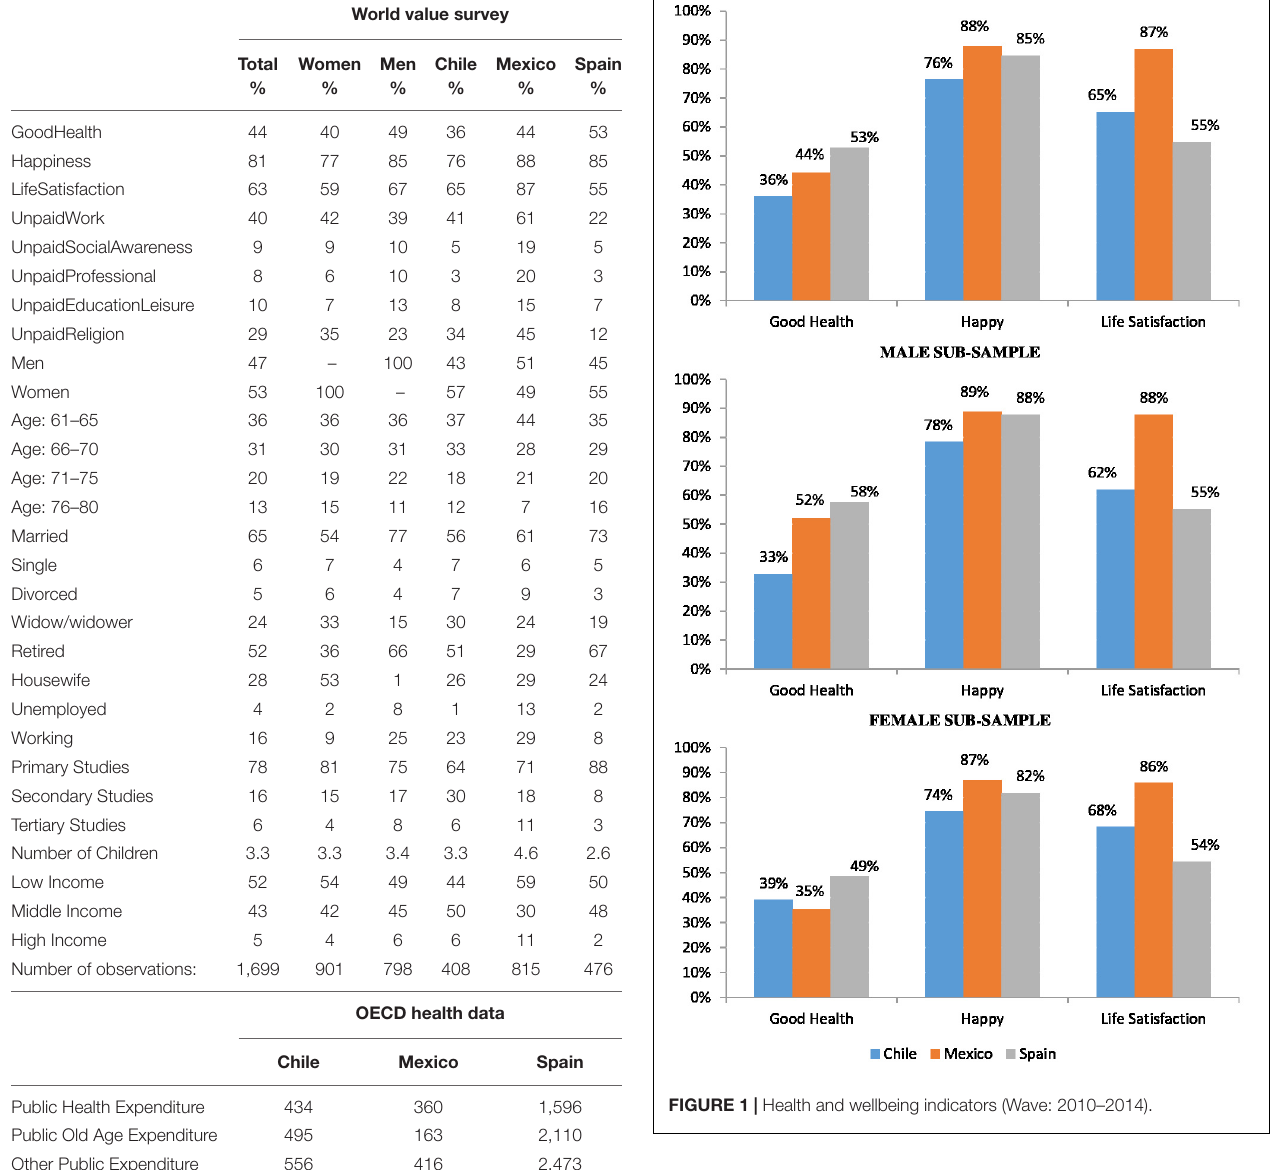
TABLE 1 | Variables (means by general category, gender, and country).